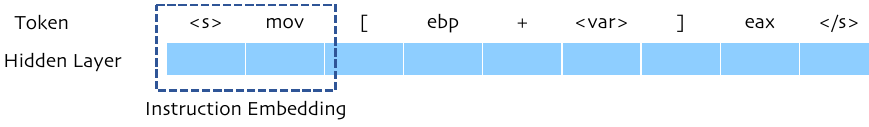
Figure 5. Instruction